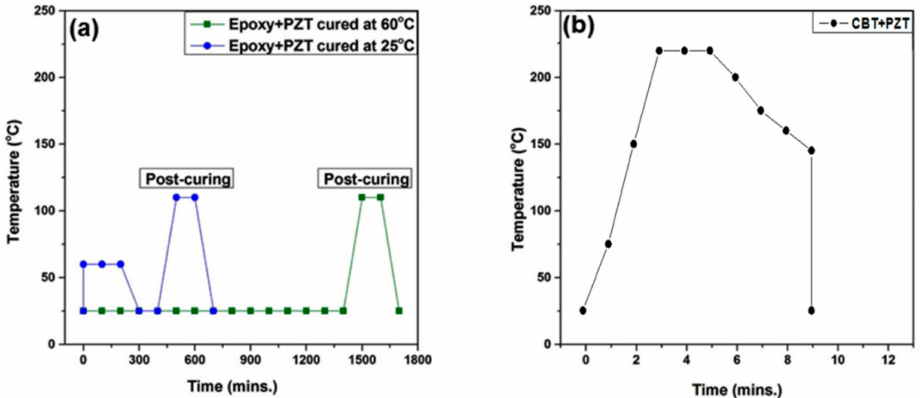
Figure 5. ( a ) Time required manufacturing a thermosetting based composite using conventional technique and ( b ) time required to prepare a thermoplastic based composite using high-temperature dielectrophoresis